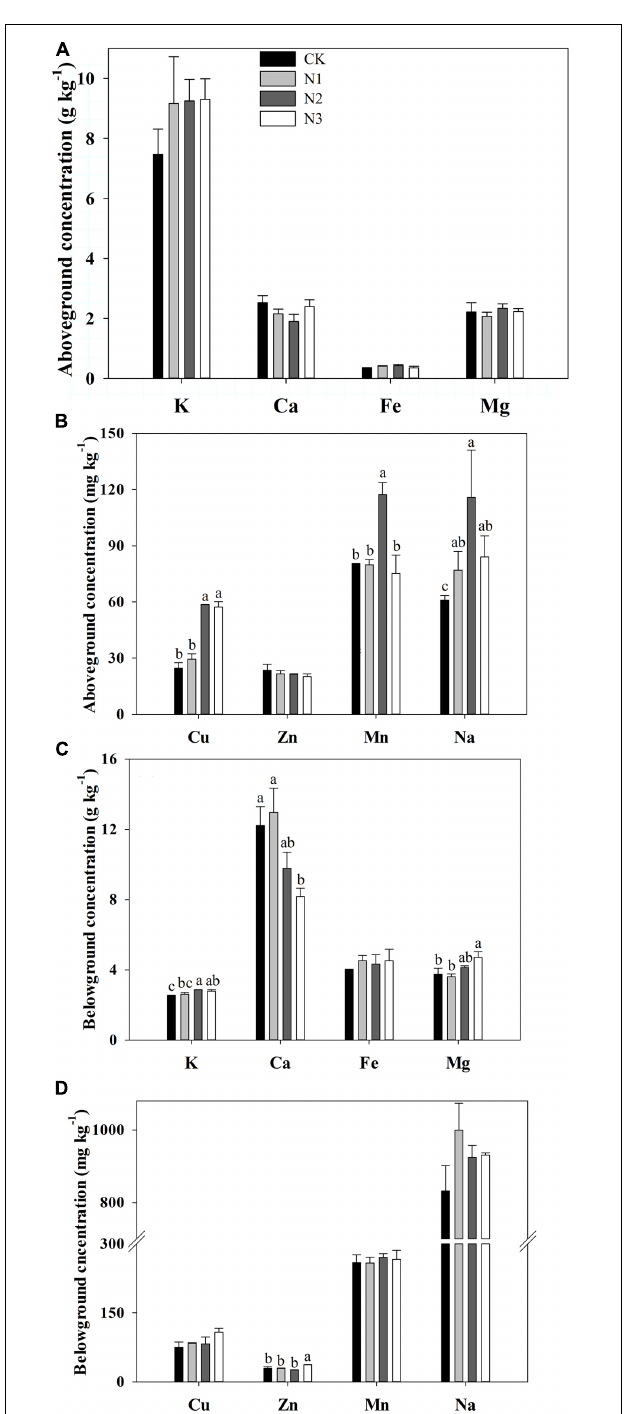
FIGURE 2 | Effects of N addition on plant biomass macro- and micronutrient concentrations in B. ischaemum . (A) The concentrations of K, Ca, Fe, and Mg in the aboveground biomass of B. ischaemum . (B) The concentrations of Cu, Zn, Mn, and Na in the aboveground biomass of B. ischaemum . (C) The concentrations of K, Ca, Fe, and Mg in the belowground biomass of B. ischaemum . (D) The concentrations of Cu, Zn, Mn, and Na in the belowground biomass of B. ischaemum . Error bars represent SE ( n = 3). Different letters above bars indicate a significant difference at P =